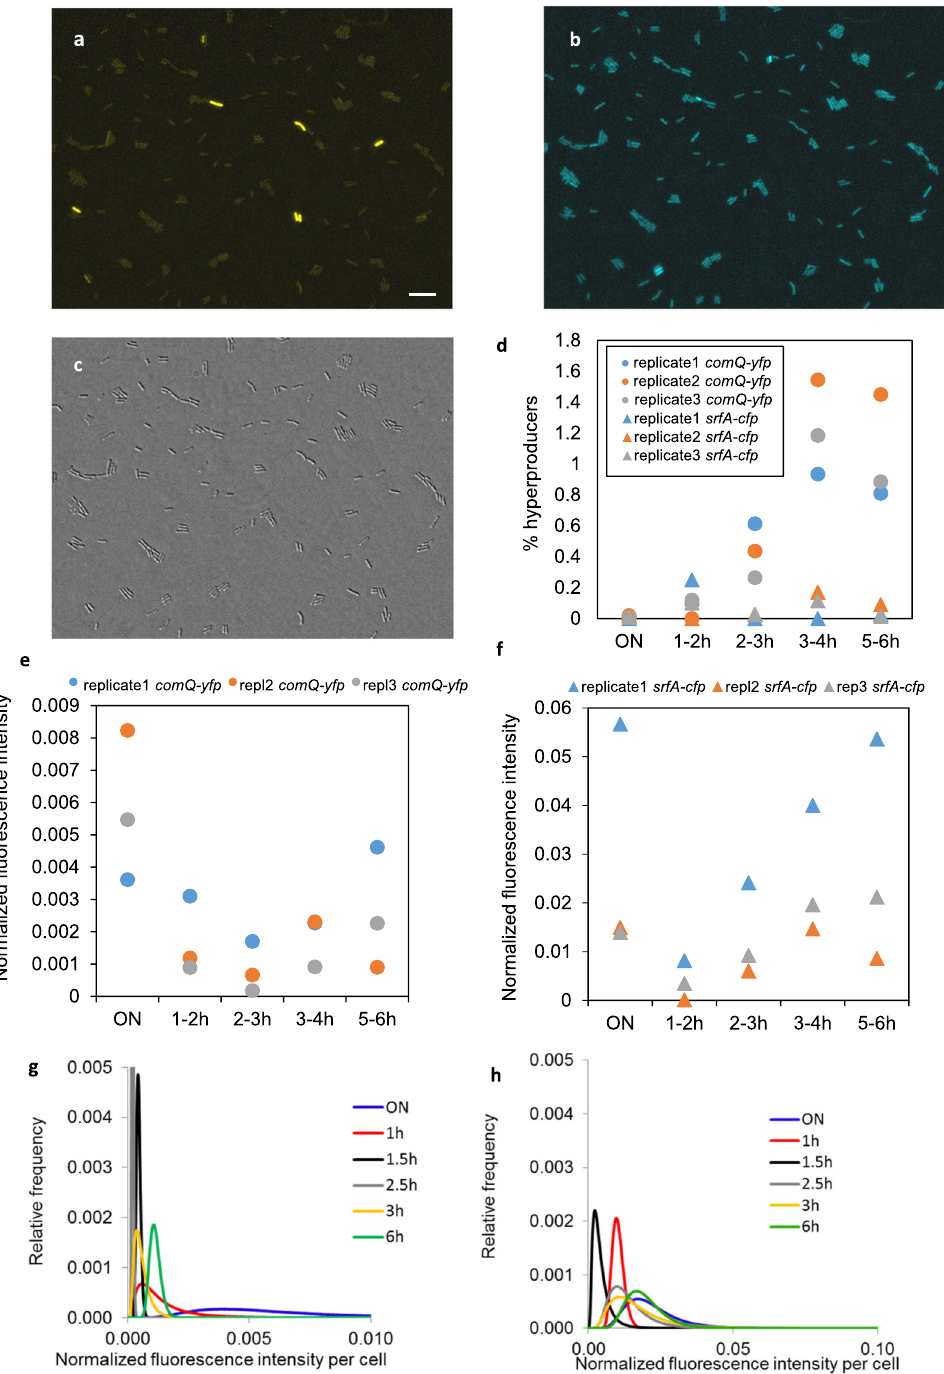
Fig. 5 Single cell quantitative fl uorescence microscopy of B. subtilis PS-216 ( comQ-yfp, srfA-cfp ). The fl uorescence microscopy images were taken periodically during incubation of B. subtilis PS-216 ( comQ-yfp, srfA-cfp ) in a batch fermenter by the YFP fi lter ( a ), CFP fi lter ( b ) or DIC ( c ). The example YFP and CFP images, taken after 3 h of incubation were pseudo-colored. The scale bar represents 10 µ m. n = 3 biologically independent experiments were performed. d % of population of cells that are hyper-expressing comQ - yfp or srfA - cfp is depicted. Gene expression level determined by single cell fl uorescence microscopy was measured as Na- fl uoresceinate standard normalized mean fl uorescence intensity per cells expressing comQ - yfp ( e ) and srfA - cfp ( f ); ON is the overnight culture. One of the three qualitatively similar cell distributions is shown in ( g ) and ( h ) for comQ - yfp and srfA - cfp , respectively; areas under the curves are the same in all time points. For additional replicate see Supplementary Fig.